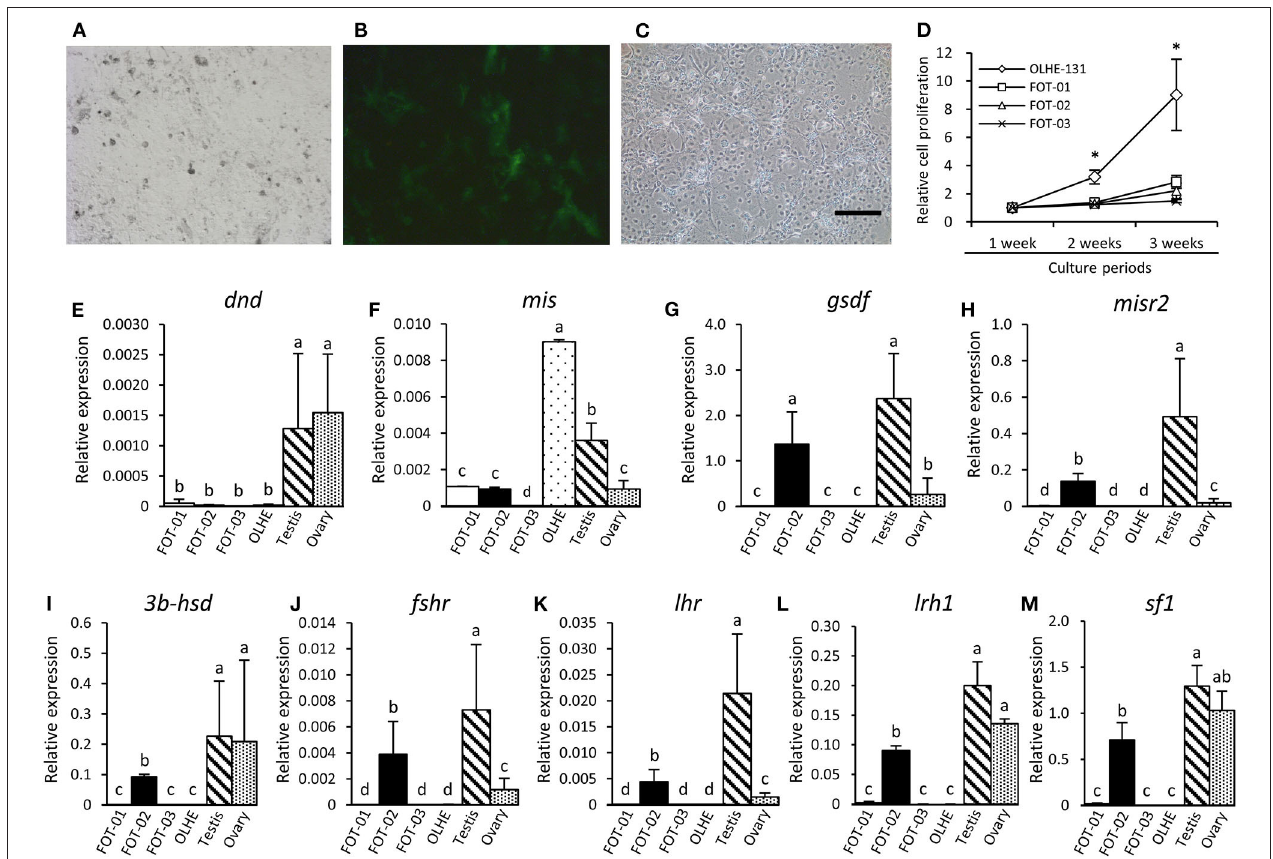
FIGURE 4 | Characteristics of the hybridoma lines derived from Sertoli cells of mis -GFP transgenic testes. GFP fluorescence in primary cultured testis cells from mis-GFP transgenic medaka in bright field (A) and in dark field (B) . Established hybridoma, FOT-02 (C) . Comparison of growth rate between established hybridomas and OLHE-131 (D) . * p < 0.05. Confirmation of mRNA expression in the hybridomas cultured for 3 weeks by qRT-PCR. The germ cell marker dnd (E) was expressed only in the testis and ovary. The gonadal somatic cell markers: mis (F) , gsdf (G) , misr2 (H) , 3b-hsd (I) , fshr (J) , lhr ( K) , lrh1 (L) , and sf1 (M) were significantly expressed in FOT-02. Relative expression was calculated based on the expression of ef1 . Scale bar: 200 µ m. Vertical bar: mean ± standard error of triplicates; a, b, c, d, and ab: significant difference ( p < 0.05) using Tukey’s multiple comparison test following one-way